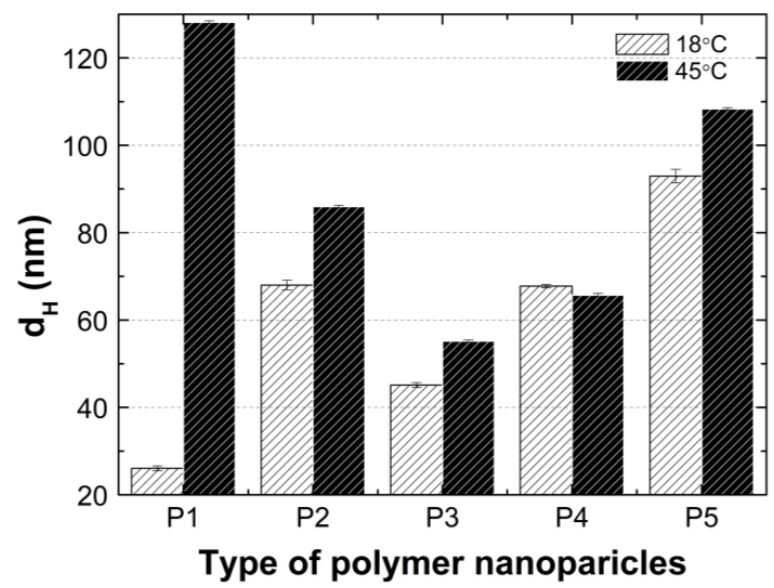
Figure 14. Hydrodynamic diameters of P1–P5 measured at 18 ◦ C and 45 ◦ C. The HD values of the tested polymer particles, except P4, are greater at 45 ◦ C than they are at 18 ◦ C (Figure 14). The increase in the temperature causes the dehydration of the oxyethylene chains and may reduce the Coulomb repulsion between the hydrophilic groups, thus leading to the formation of large aggregates [85]. The size of the aggregates with the increase of the PEGMEM chain length decreased for polymers P1–P3 and